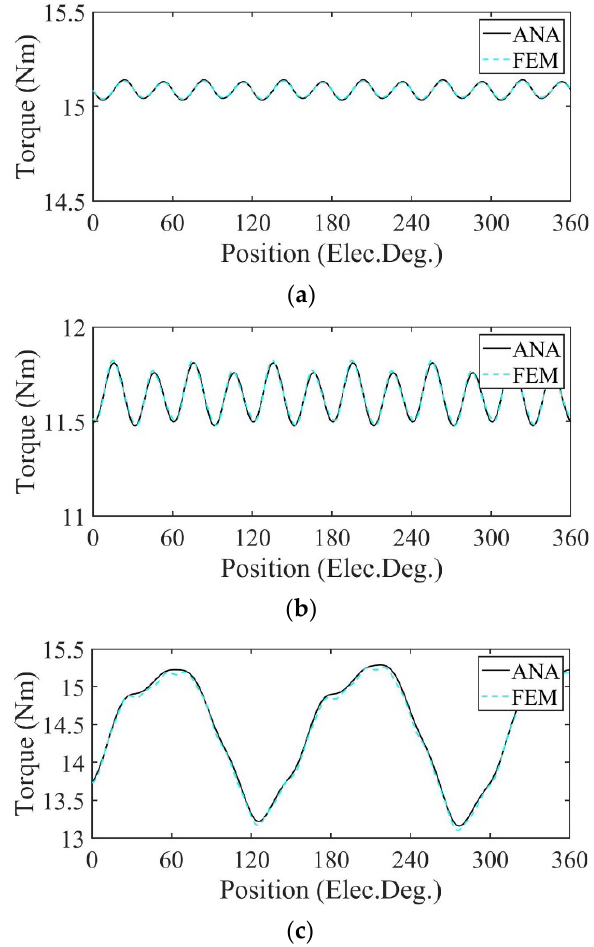
Figure 15. Output torque comparison. ( a ) Healthy; ( b ) uniform demagnetization; ( c ) partial demag- netization.